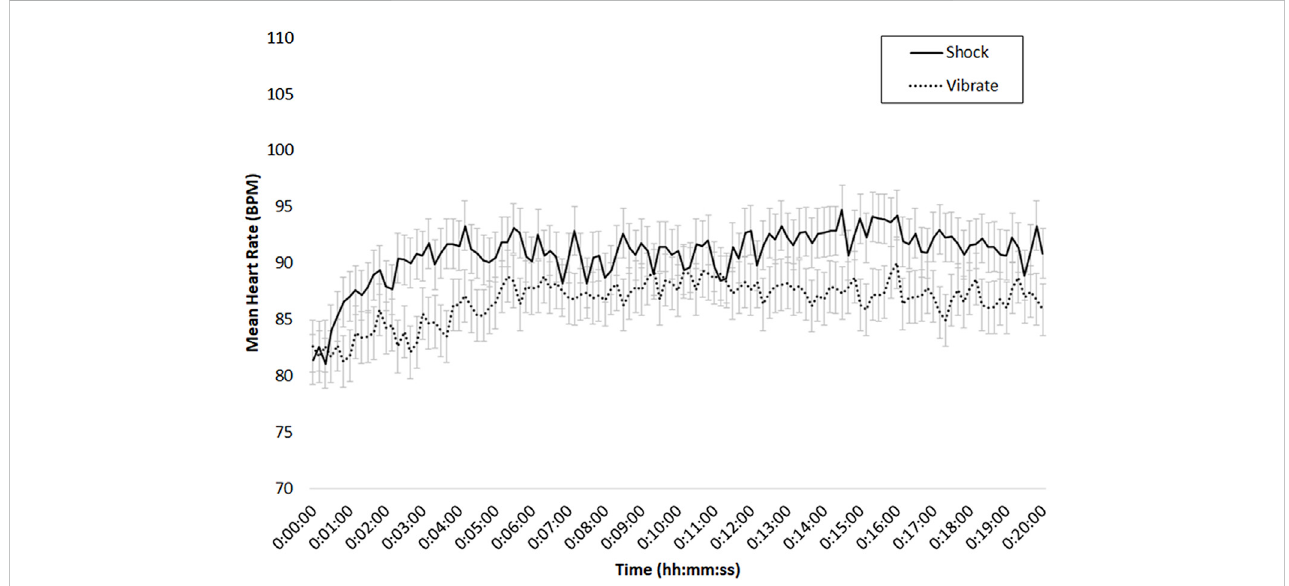
FIGURE 7 Mean heartrate (BPM)intheshock(solid) versus vibrate (dotted) condition, for the20-min periodof theDeMUS scenario; barsindicate standarderror of the mean.